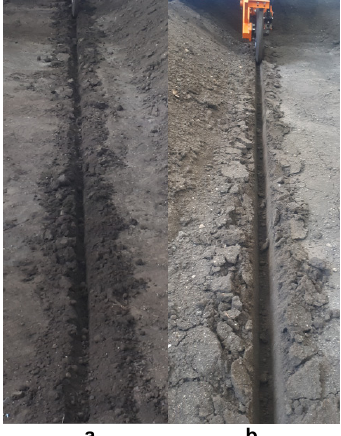
Figure 15. A furrow left after the passage of the sowing section: а - the sowing section with the installed slotting